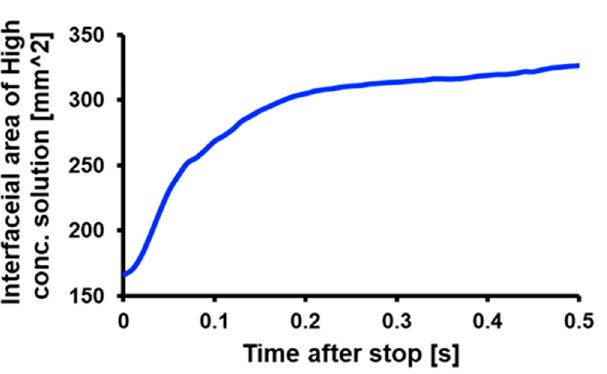
Figure 11. Calculated variation in interfacial area between high and low concentration.